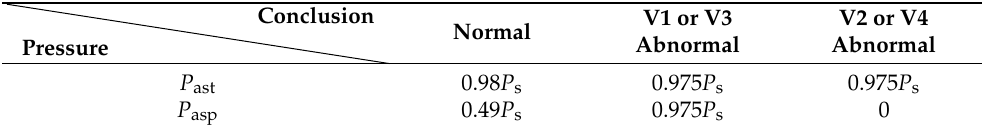
Table 2. Judgment rules of solenoid valve state.